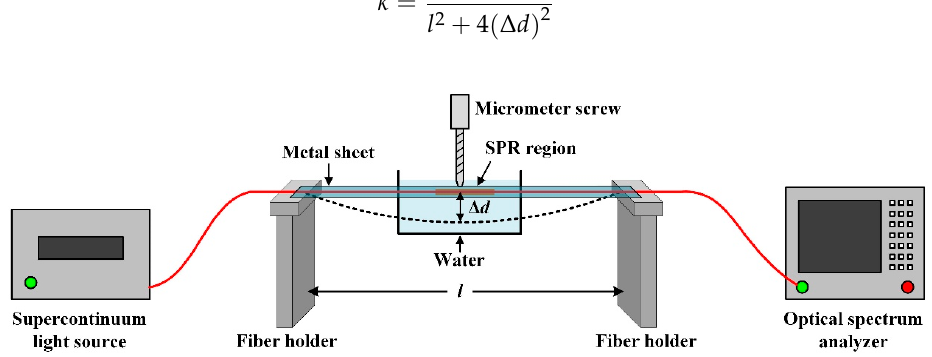
Figure 4. The sketch diagram of the fiber SPR bending sensor experiment system.